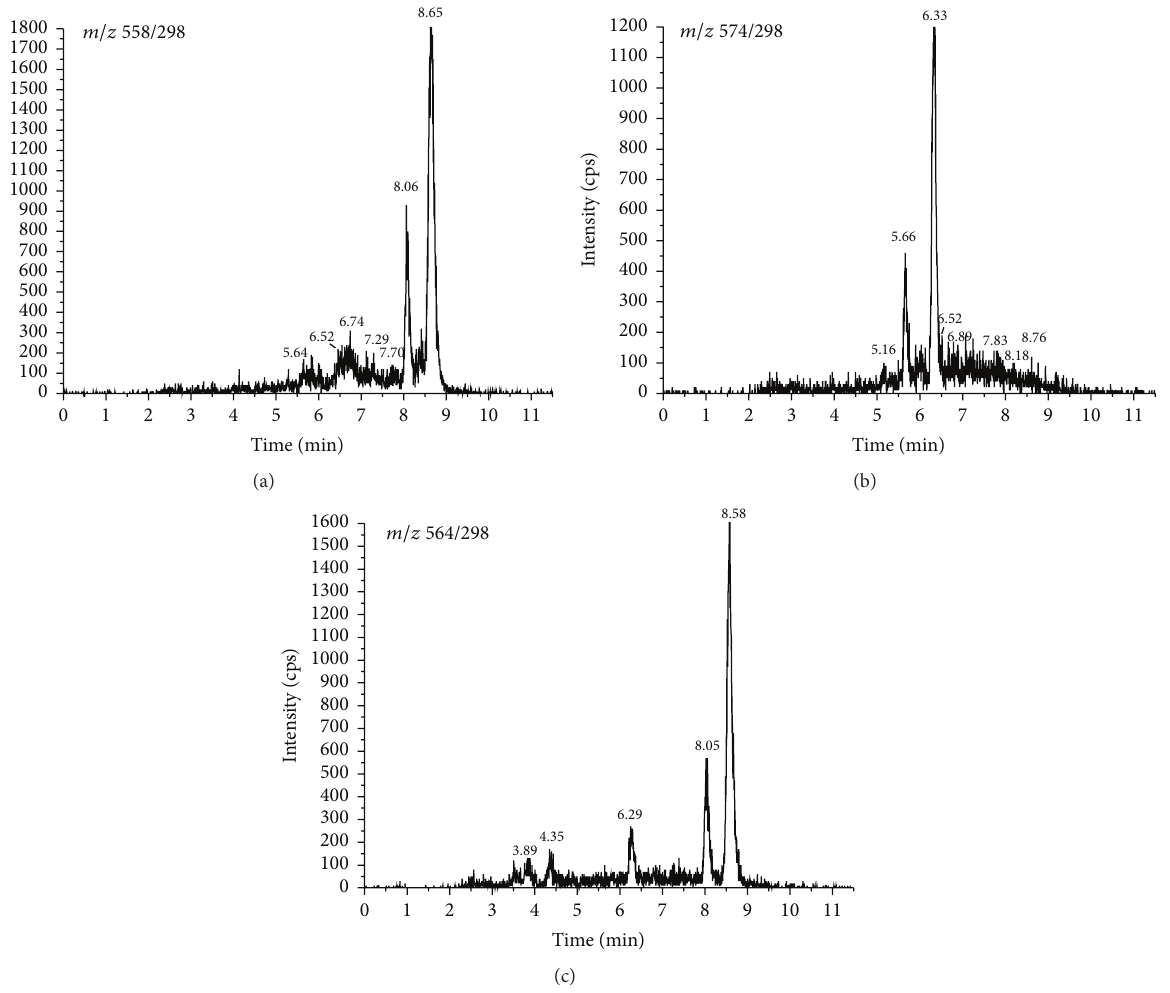
Figure 3: The representative MRM chromatograms for 25(OH)D 3 -PTAD (a), 24,25(OH) 2 D 3 -PTAD (b), and d6-25(OH)D 3 -PTAD (c) of brain tissue.